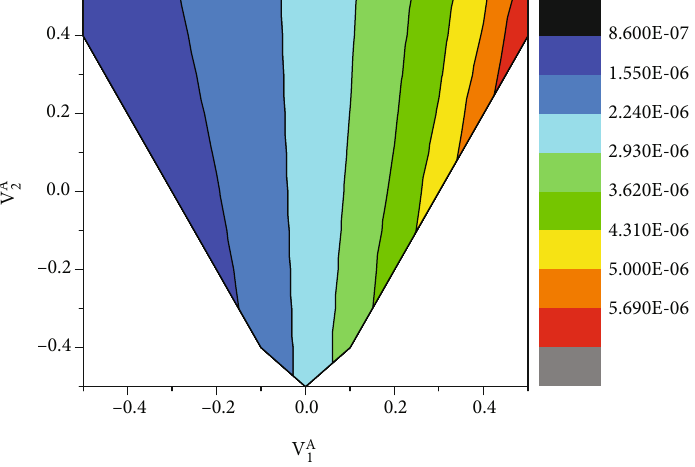
Figure 12: CTE_y contours of V A